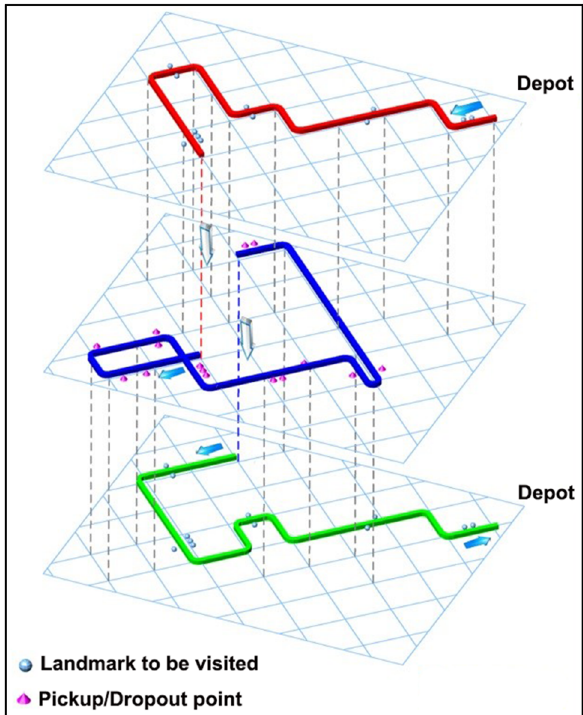
Fig. 7 Augmenting paths of the network in Fig. 4 in three indepen- dent layers